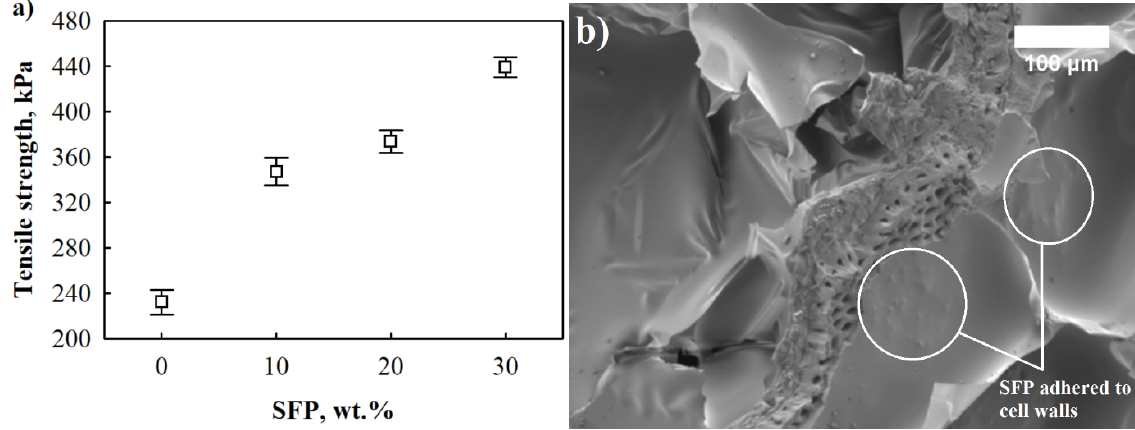
Figure 6. Tensile strength of SFP filler-modified PUR foams and SFP filler interaction with polyurethane foam matrix: ( a ) tensile strength; ( b ) SFP filler particle after tensile strength test (×200 magnification).